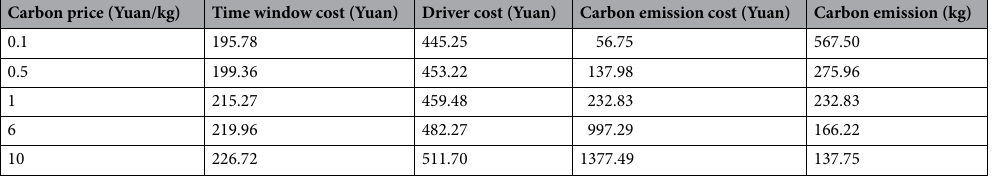
Table 5. The effect of various carbon prices.